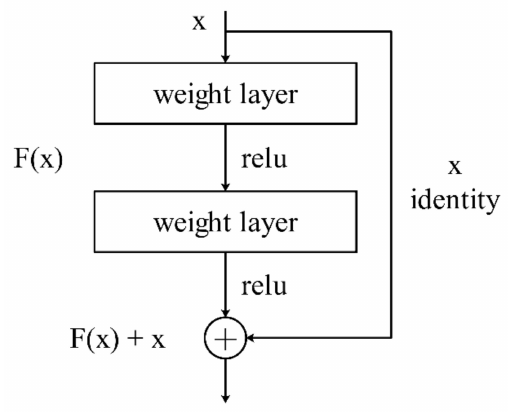
Figure 1. Residual